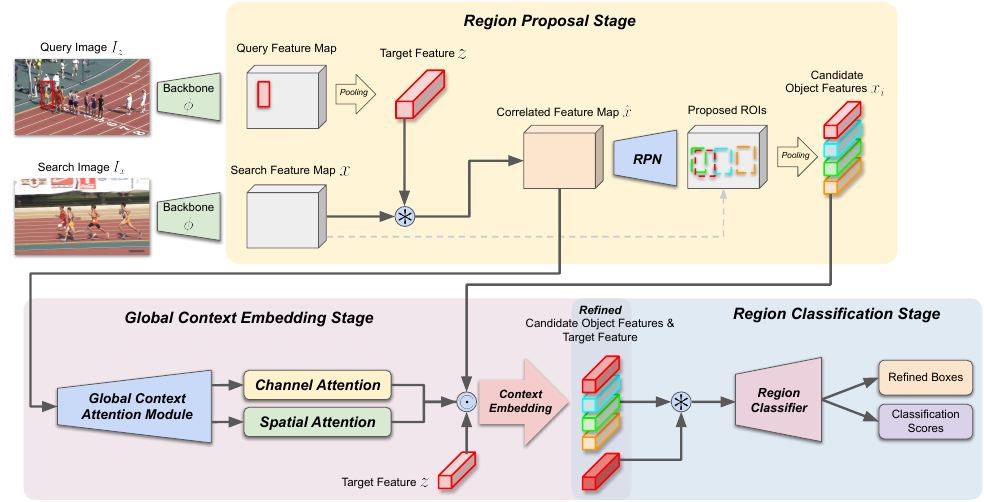
Figure 2. Overview for the proposed tracking